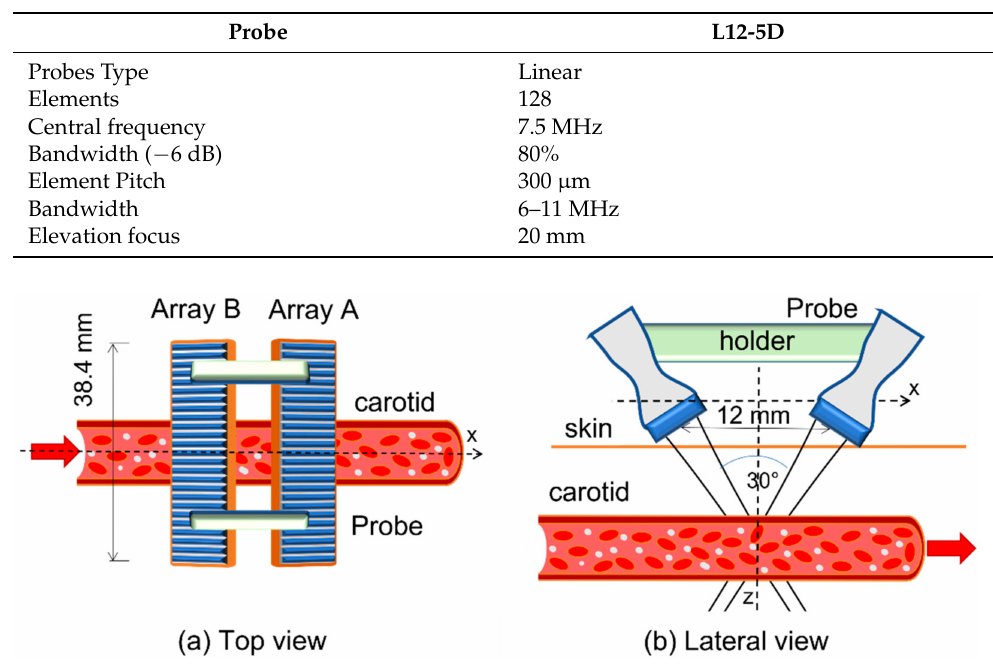
Table 1. Probe details.